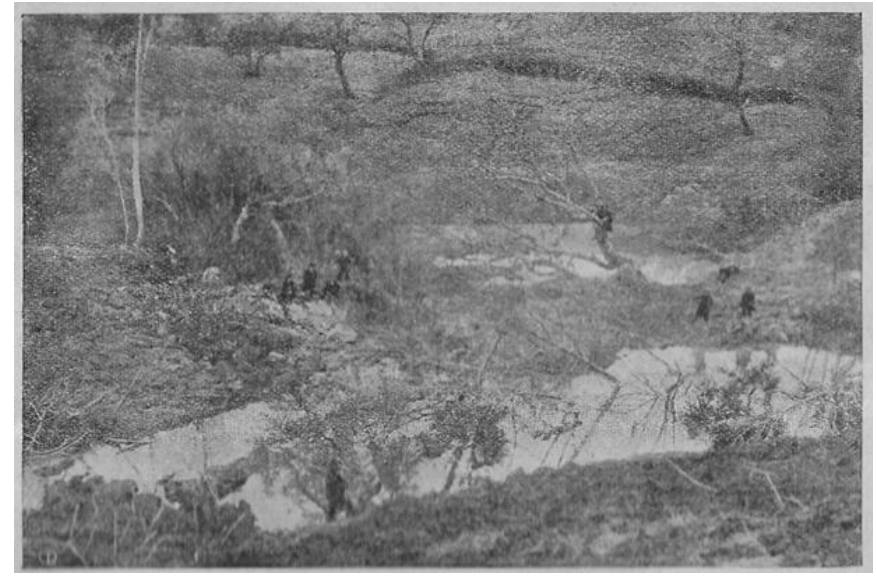
Figure 14. Ponds on the landslide body (Source: [67], private archive of Gizzi F.T.).